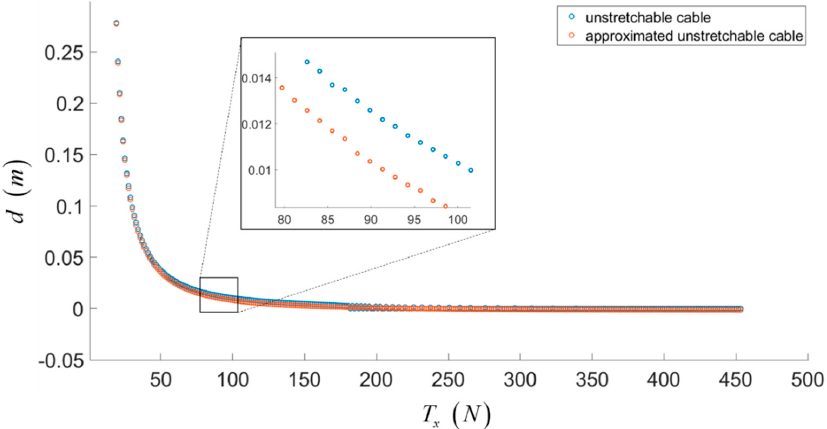
Figure 9. The relationship between d and m that concerns to the unstretchable cable and the approximated one.